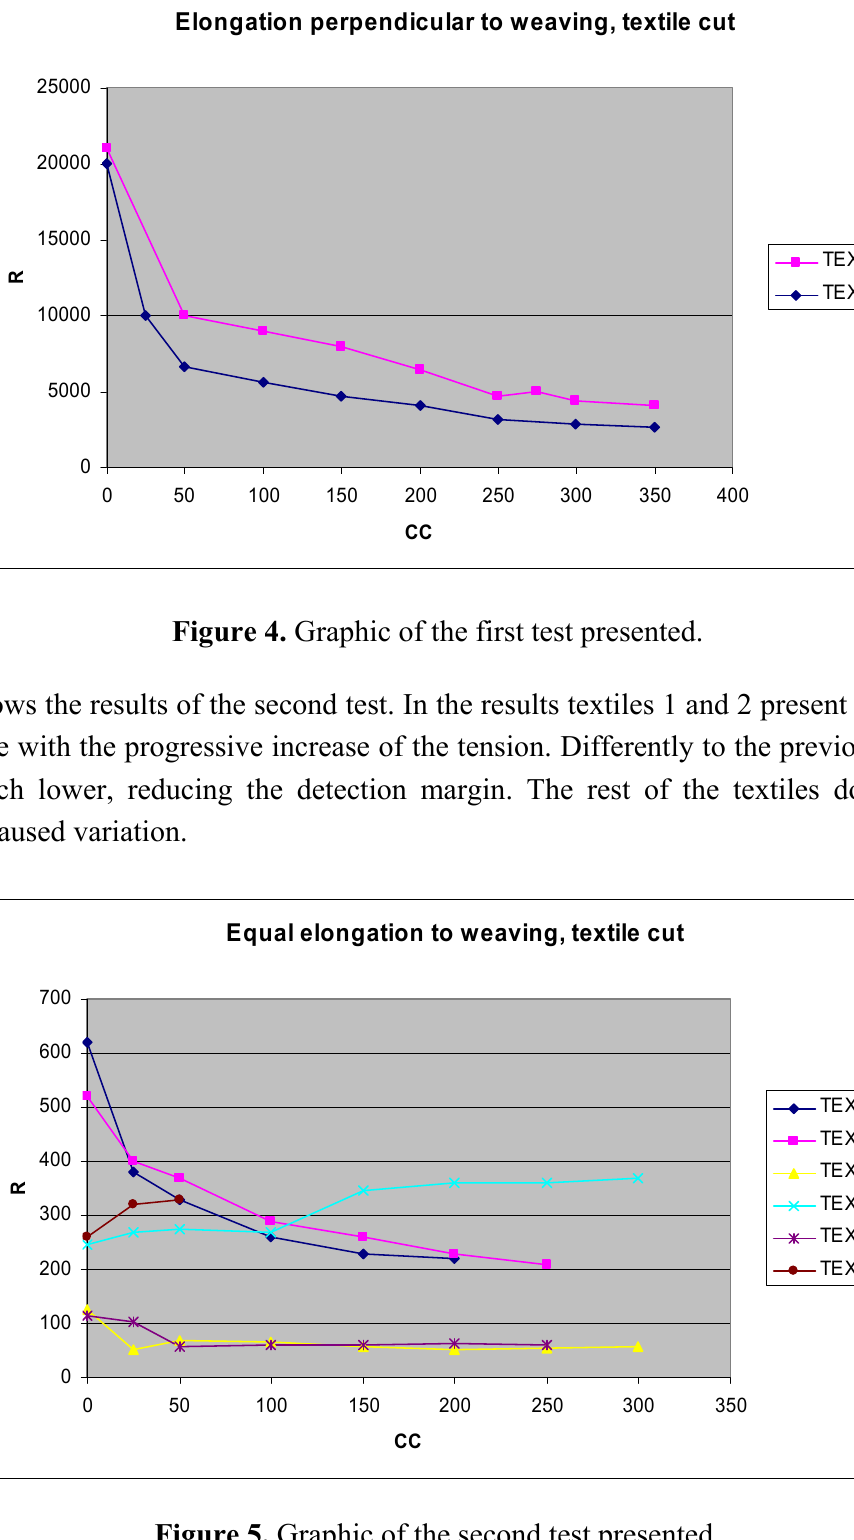
Figure 5. Graphic of the second test